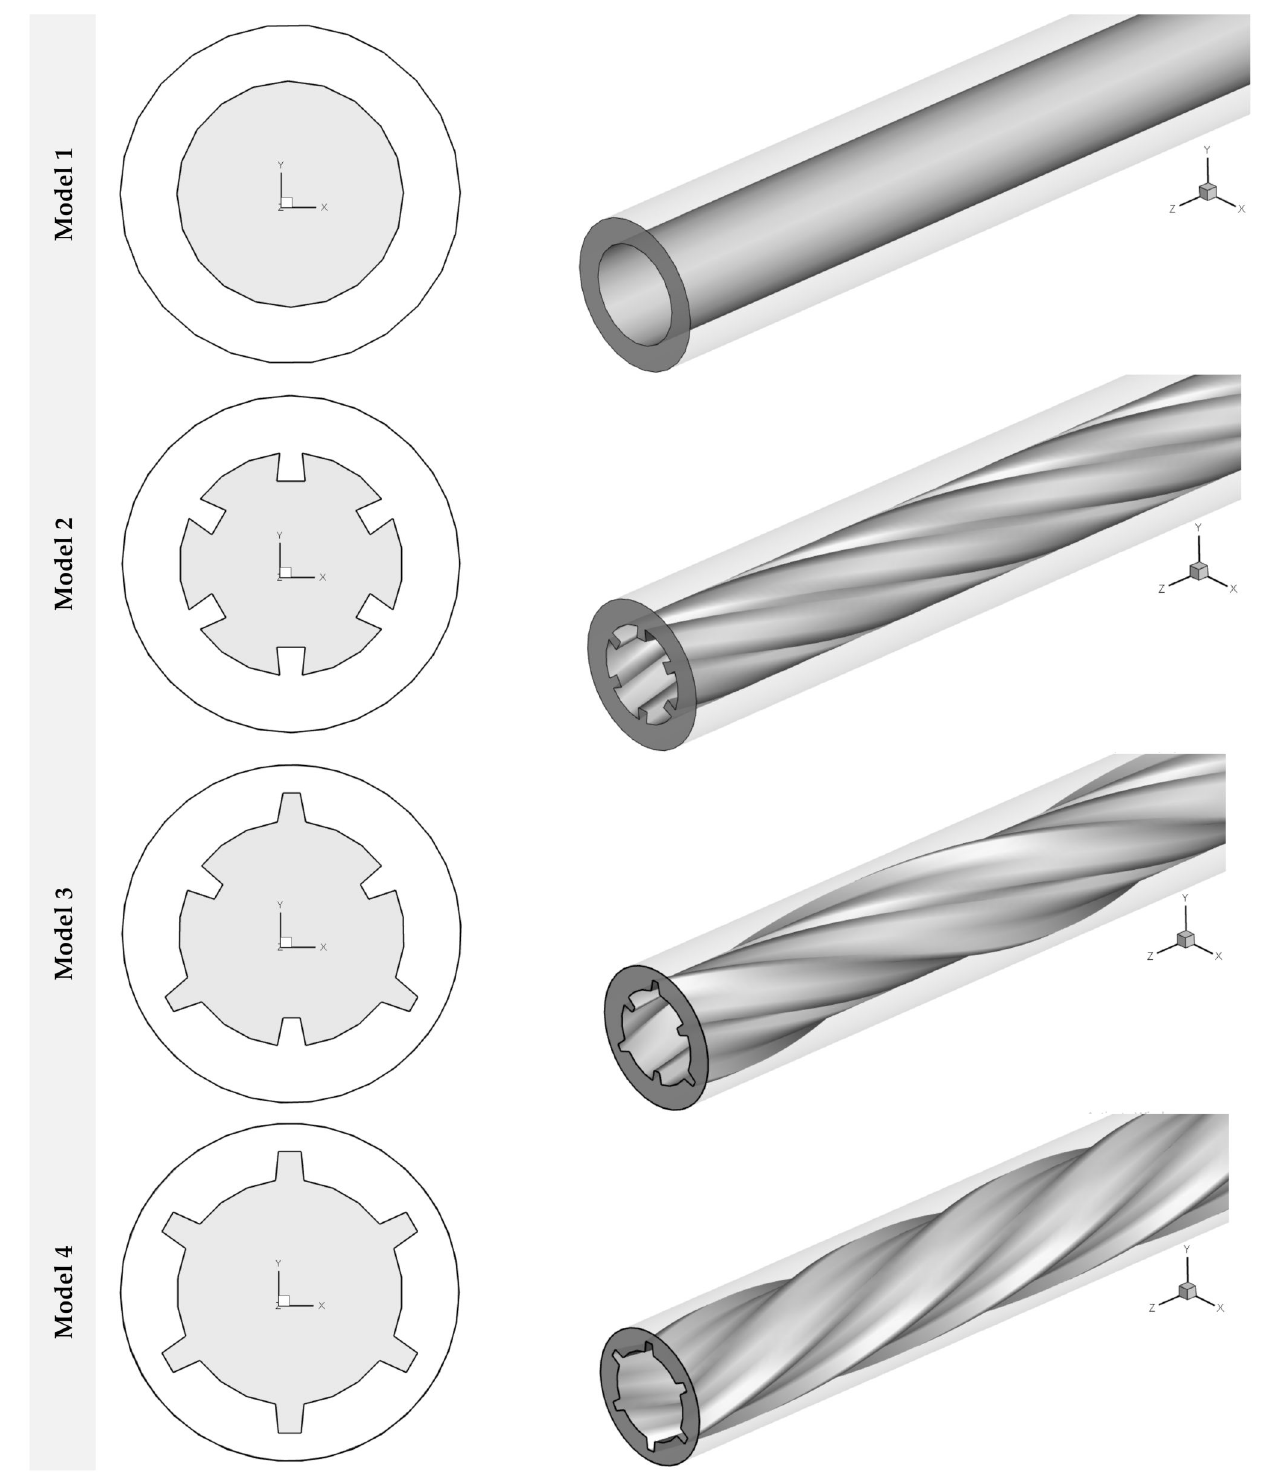
Figure 2. The schematics of the evaluated geometries in the first section of present